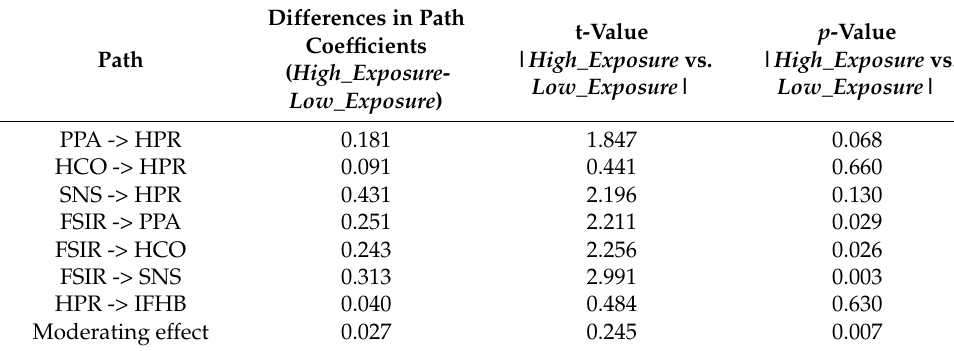
Table 10. Welch–Satterthwaite test for the effects of different COVID-19 exposure levels. Differences in Path t-Value Coefficients Path | High_Exposure vs. ( High_Exposure - Low_Exposure Low_Exposure )